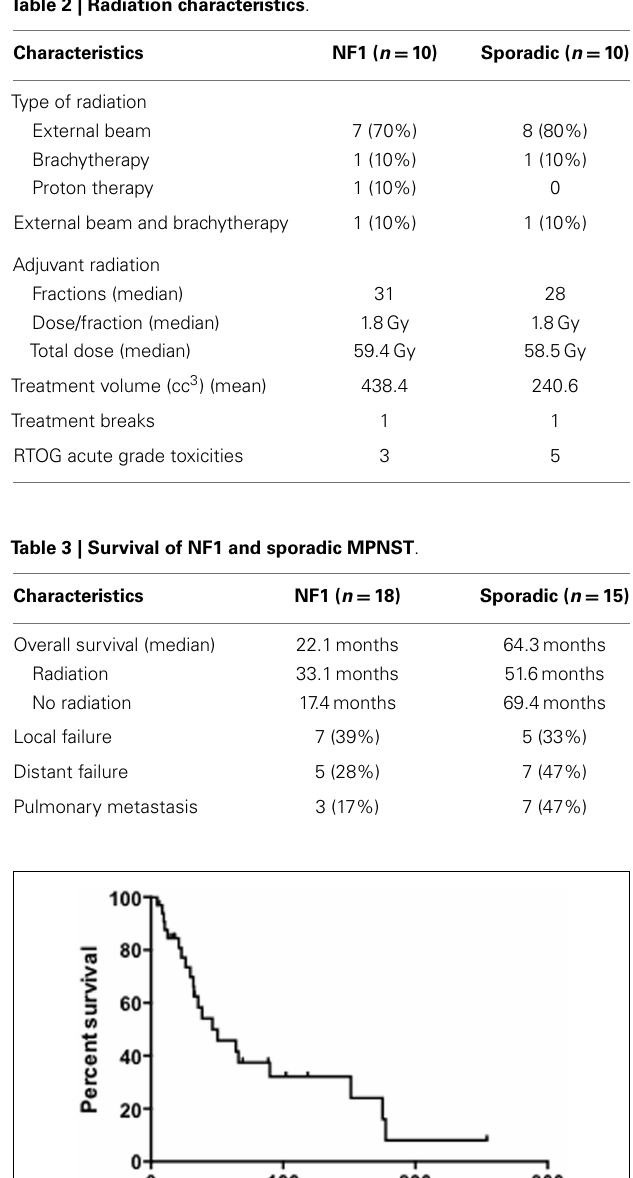
Table 2 | Radiation characteristics .